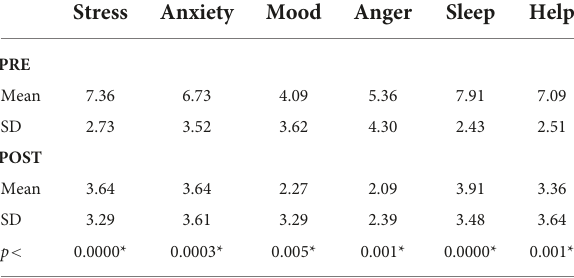
TABLE 2 Emotion thermometer: Average scores, standard deviations, and significance